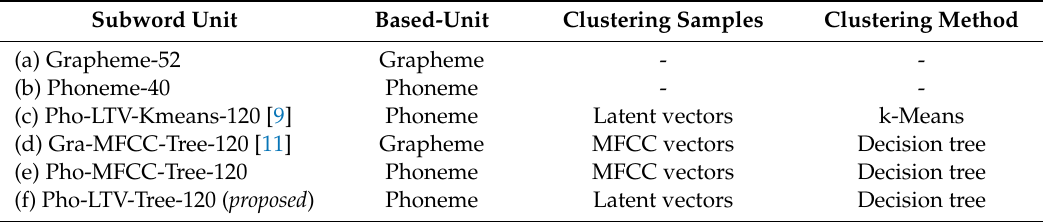
Table 1. Summary of the subword units obtained in the various